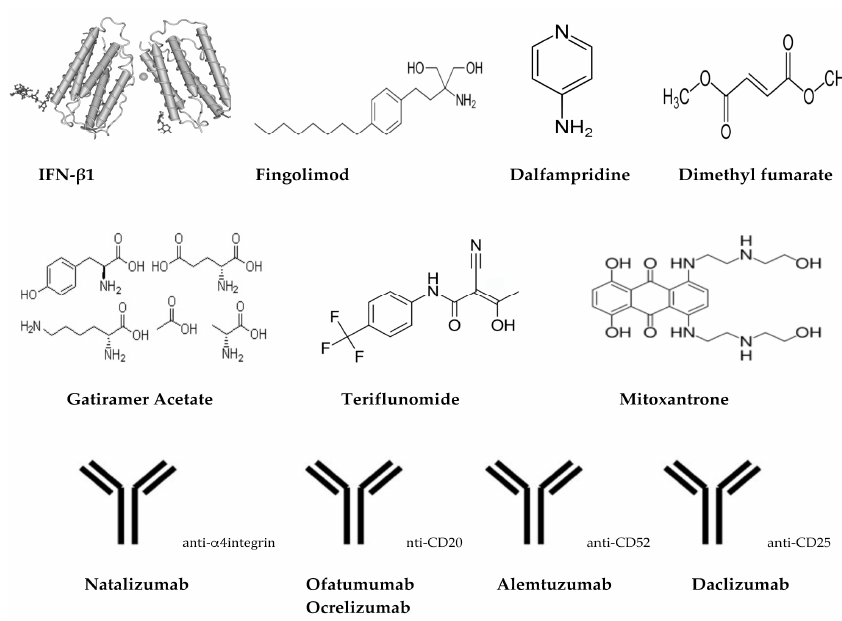
Figure 2. Chemical/schematic structures of treatments/drugs for MS. Table 1. Disease ‐ modifying drugs available to patients with RRMS.